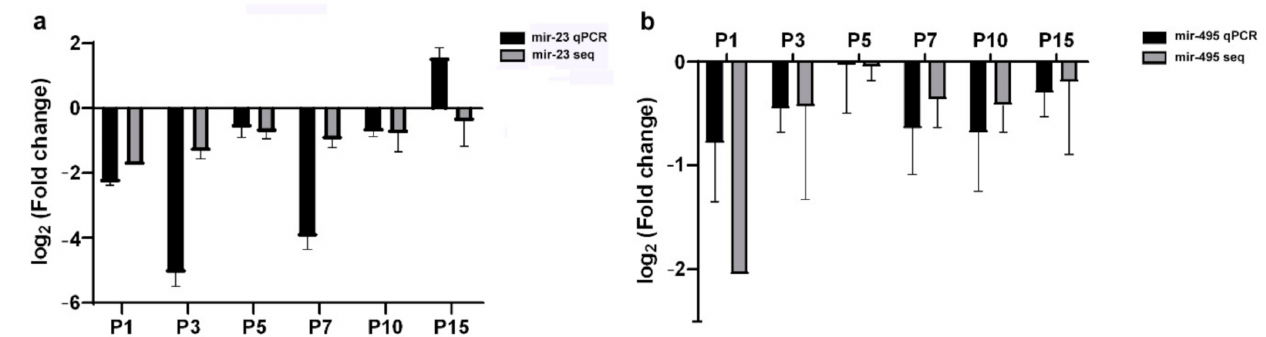
Figure 1. The expression alteration of miR-23 ( a ) and miR-495 ( b ) revealed by RNA-sequencing (grey) and RT-qPCR measurements (black). Fold changes are represented as log2 Fold change compared to P21 (Table S1).